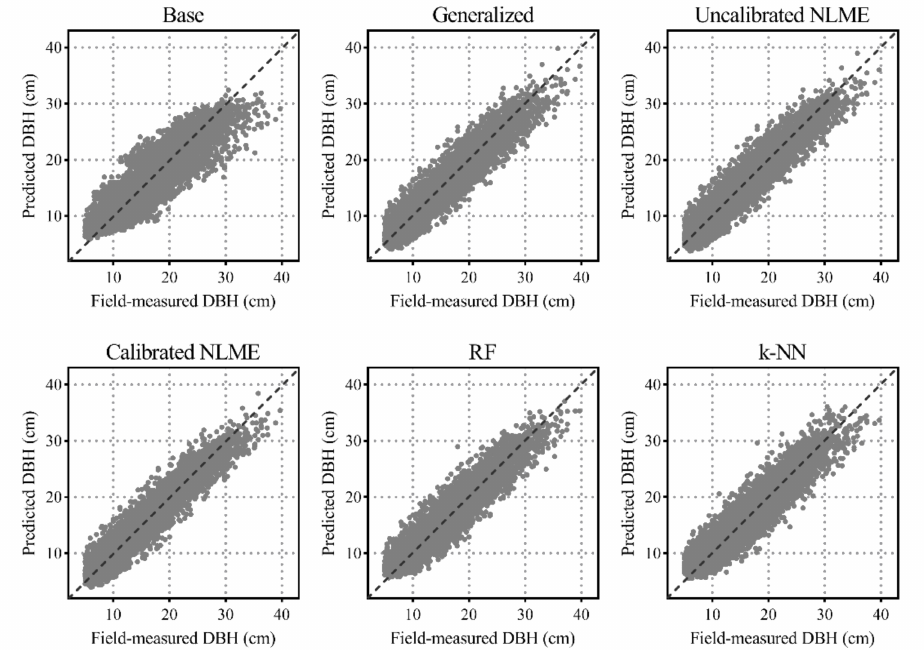
Figure 5. The predicted vs. field-measured diameter at breast height (DBH) for 8364 correctly delineated trees calculated using six different methods.